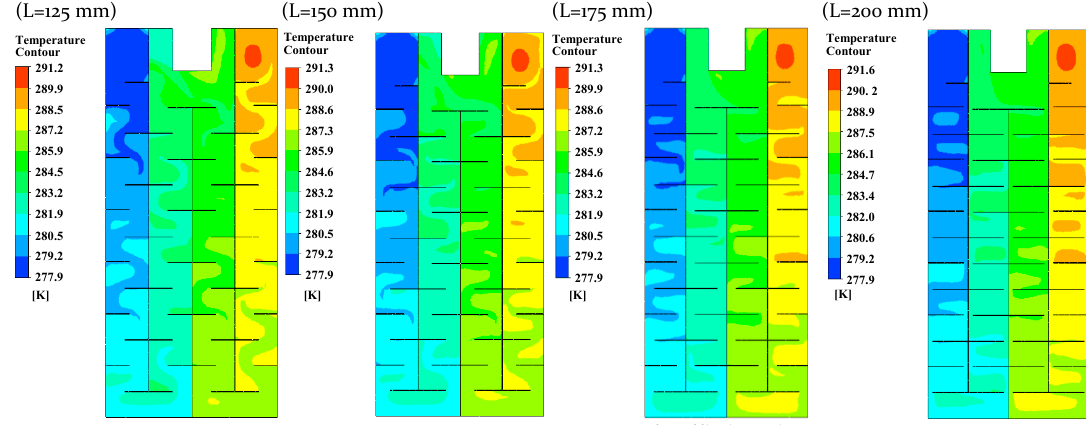
Figure 6. Temperature contours of Baffle lengths